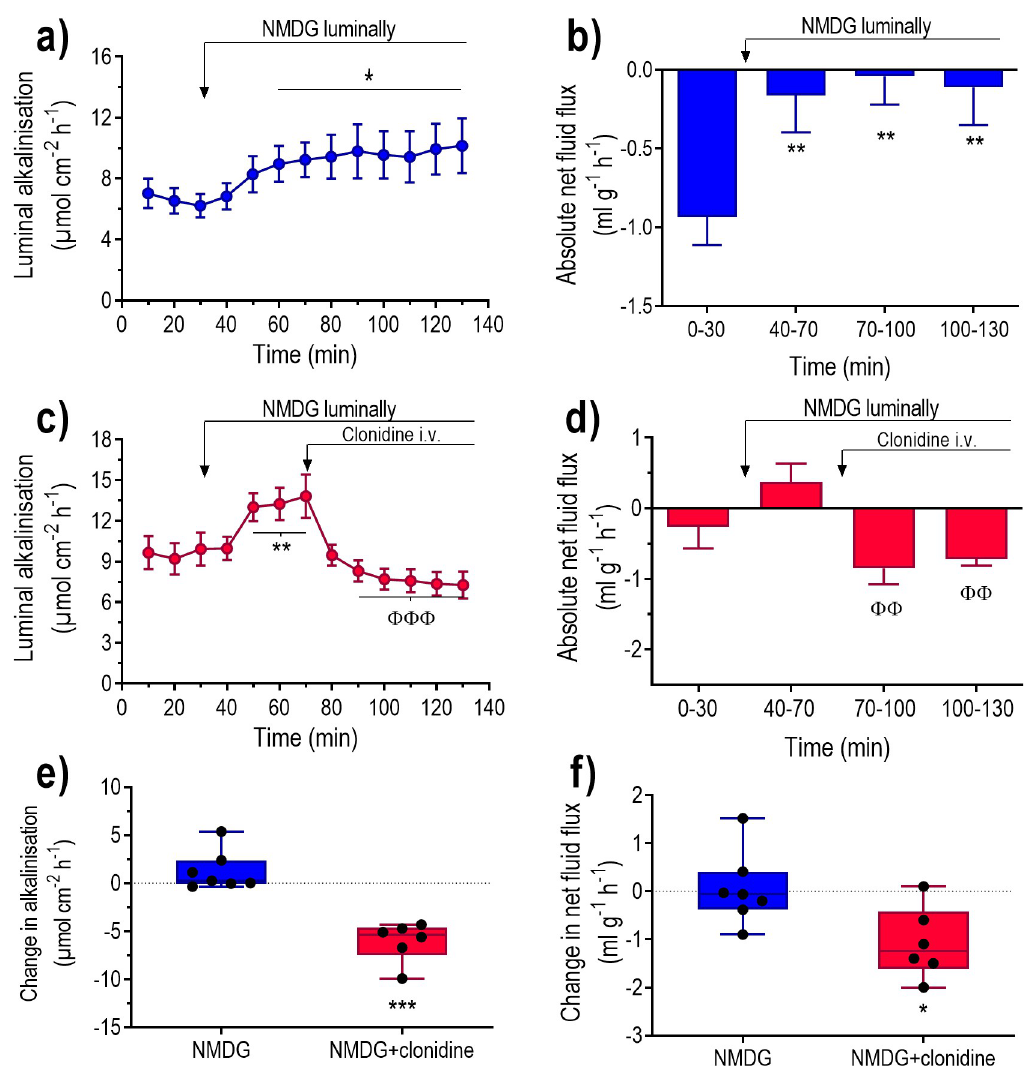
Fig 5. The effects of clonidine on fluid flux and luminal alkalinisation in rat duodenum perfused with an isotonic Na + -free solution. The duodenum was perfused with isotonic saline for 30 min, followed by an isotonic Na + -free NMDG chloride solution for 100 min (Fig 1). Effects on luminal alkalinisation (a and c) and transepithelial net fluid flux (b and d) in the absence and presence of i.v. infusion of clonidine at a dose of 10 μ g kg -1 h -1 . Net changes in (e) luminal alkalinisation and (f) transepithelial net fluid flux between 110–130 min and 50–70 min (NMDG plus clonidine vs. NMDG alone). Values are means ± SEM or box plots with all individual points. � P < 0.05 and �� P < 0.01 compared with basal values. FF P < 0.01 and FFF P < 0.001 compared with values at 40–70 min. Fig (e) and (f); � P < 0.05 and ��� P < 0.001 compared with values in animals treated with NMDG alone.